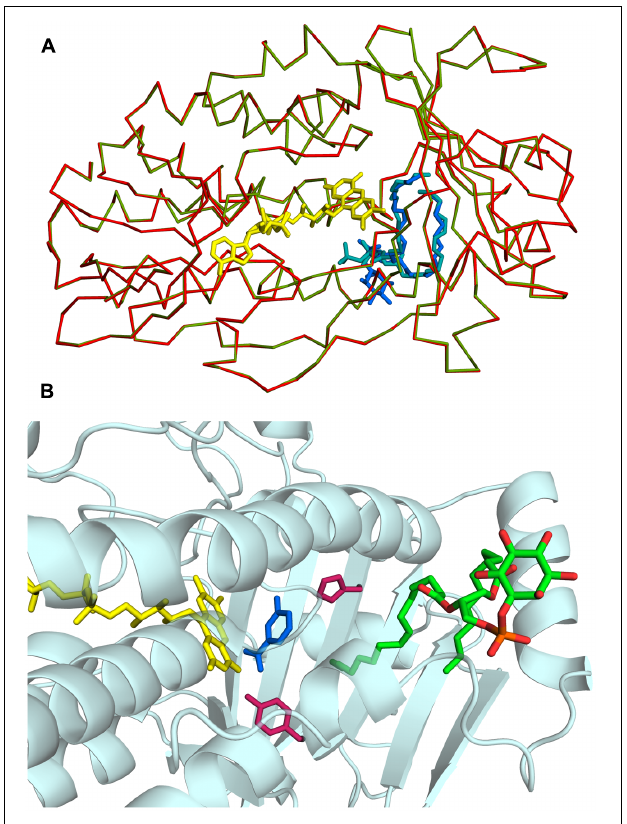
FIGURE 2 | Three-dimensional structure of Rj 3HB6H. (A) View of α -carbon traces of the refined structures of 3HB6H (green; pdb code 4BJZ) and Rj 3HB6H (red; pdb code 5HYM), following superposition of corresponding main chain atoms. FAD is shown as a stick model in yellow. The lipid ligands are shown as stick models in shades of blue in the back of the protein. (B) The phospholipid is located in a tunnel, which runs from the dimer interface to the active site. The FAD cofactor is depicted in yellow. The lipid cofactor is colored by elements, and the active site residues His213 and Tyr217 are in dark red. The 3-hydroxybenzoate in blue is a superposition from the structure of the 3HB6H variant H213S, which contains bound substrate (pdb code 4bk1).